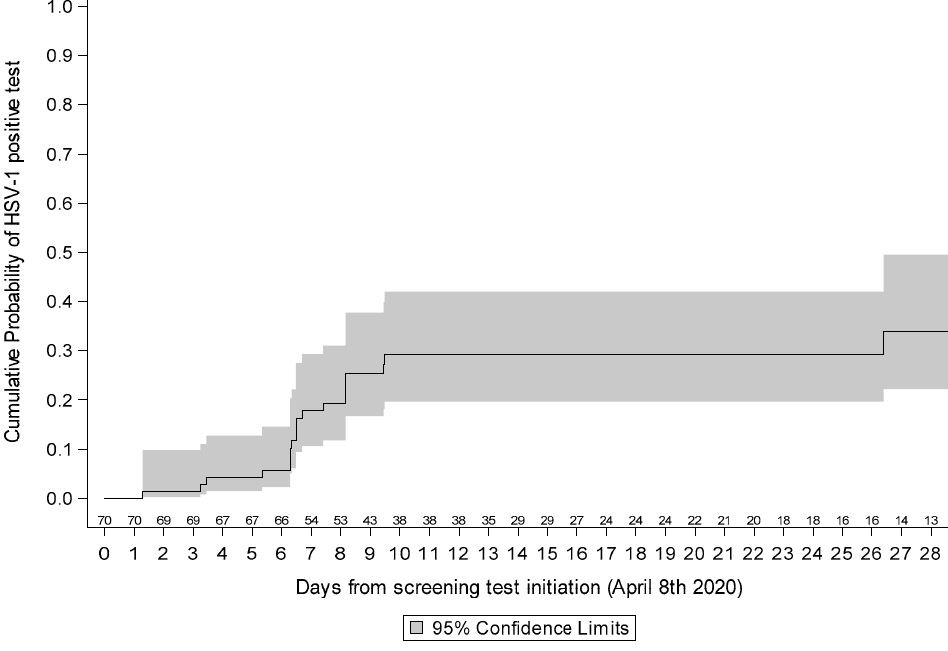
Table 2. Logistic regression estimates of the risk of HSV-1 infection.